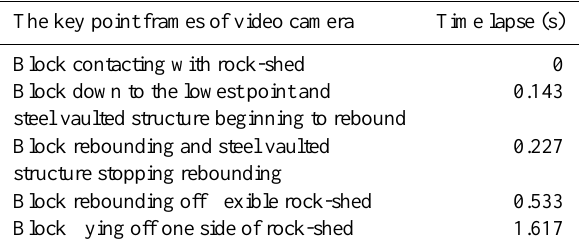
Table 1. The time lapse from the first contact of the block with the flexible rock-shed.